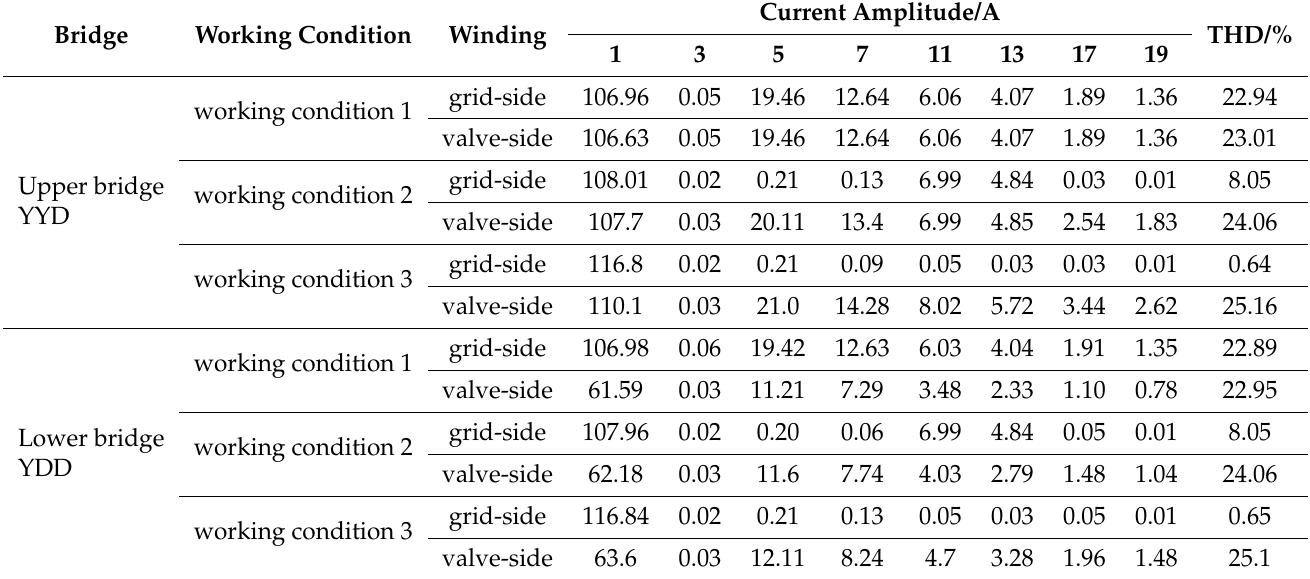
Table 3. Simulation results of winding current at the grid-side and winding current at the valve-side of the integrated multi-winding inductive filter converter transformer